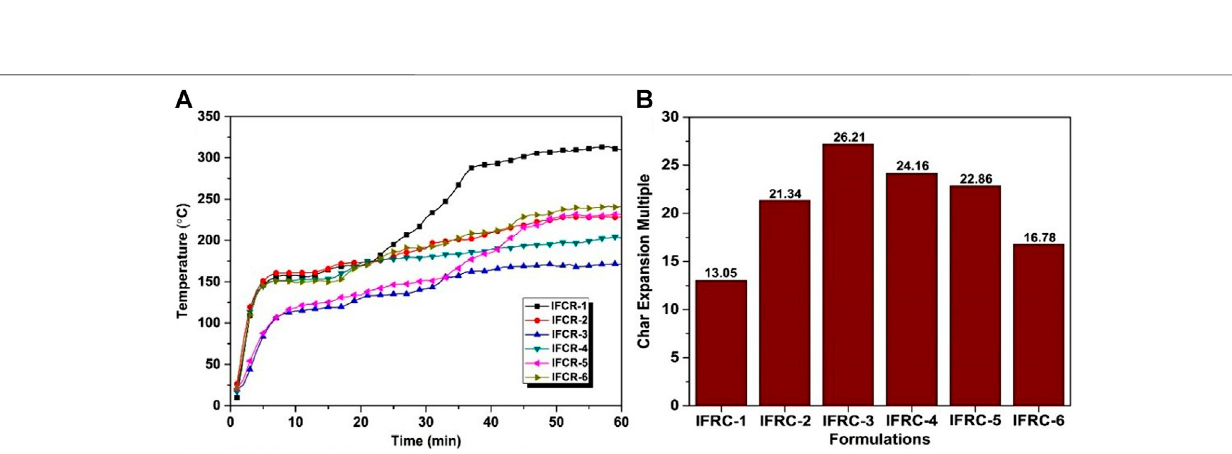
Frontiers in Materials |